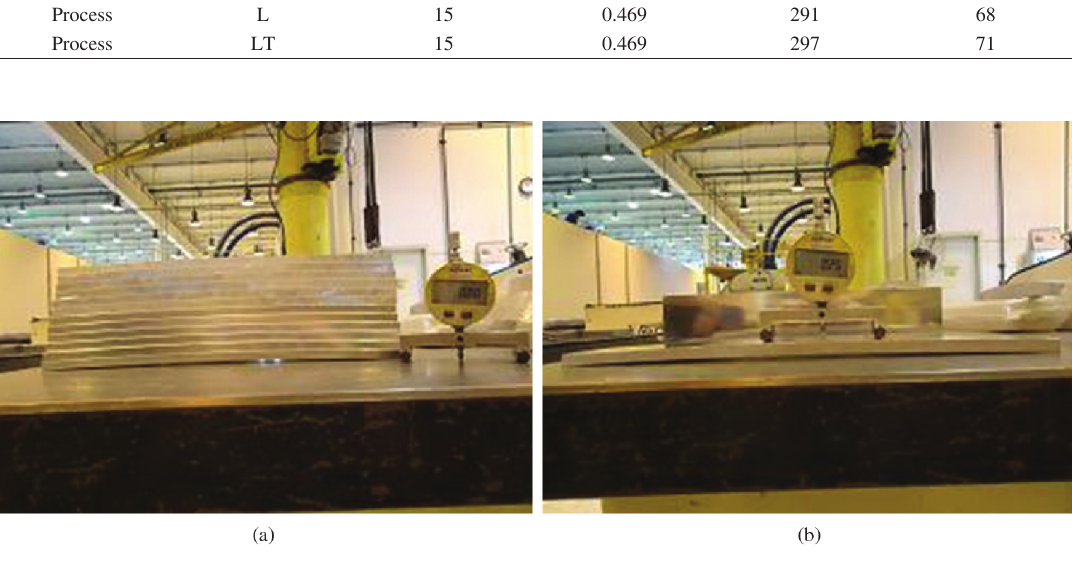
Table 3. Values of initial stresses involved in CAF and the corresponding percentage of σ